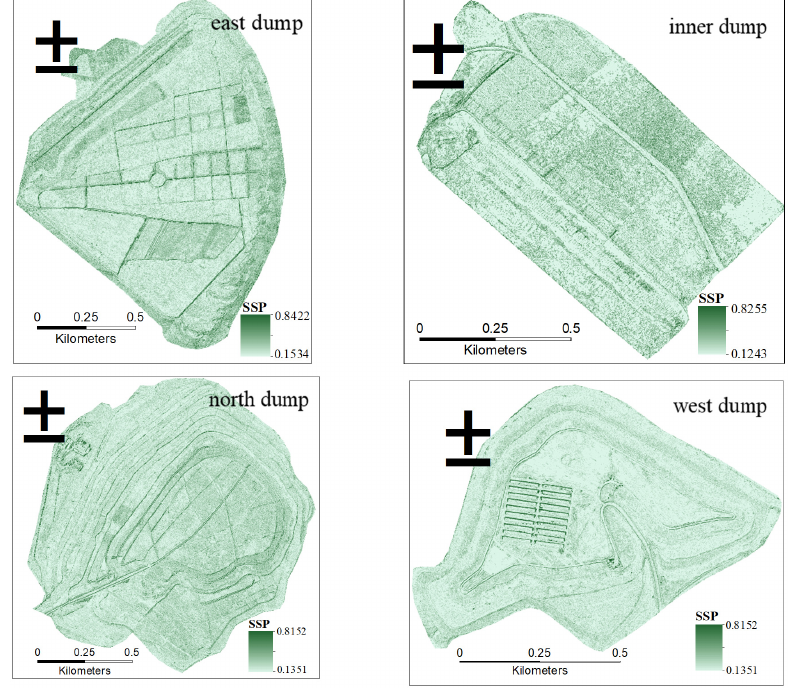
Figure 5. Spatial distribution of forest spatial structure in Heidaigou open-pit coal mine in the: east dump, inner dump, north dump, and west dump.